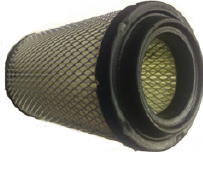
Figure 2. Filter Figure 2. Filter cartridge.